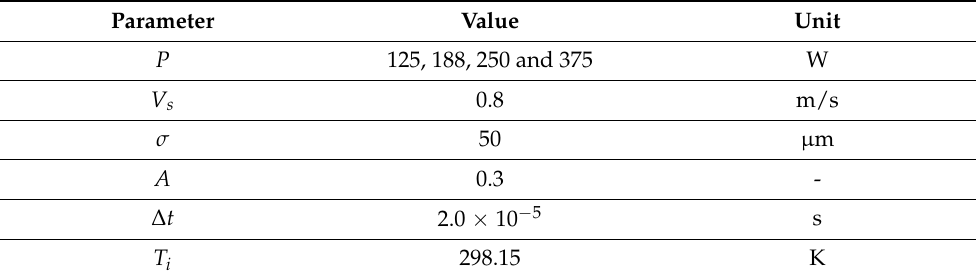
Table 2. Process and material parameters used in the current